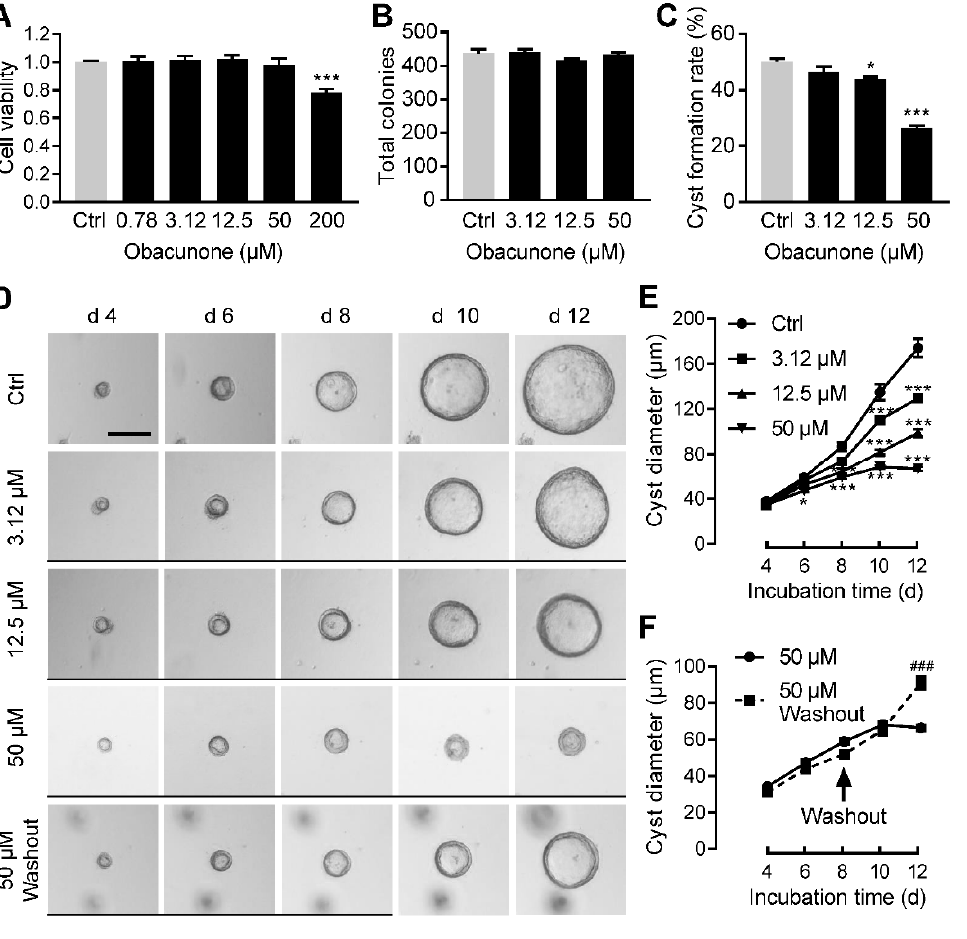
Figure 2. Inhibitory effect of obacunone on MDCK cyst formation and expansion. ( A ) Viability of MDCK cells treated without (Ctrl) or with obacunone. n = 5. ( B ) Number of total colonies in MDCK cyst model. n = 3. ( C ) Cyst formation rate. n = 3. ( D ) Representative images of MDCK cysts. Narrow black lines indicate obacunone treatment. Bar = 100 μ m. ( E ) Diameters of MDCK cysts showing dose response of obacunone. n = 30. ( F ) Diameter of MDCK cysts showing reversible effect of obacunone. Arrow indicates the time of washout obacunone. n = 30. Data are presented as means ± SEM. * p < 0.05, *** p < 0.001 versus Ctrl. ### p < 0.001 versus 50 μ M obacunone treatment without washout.